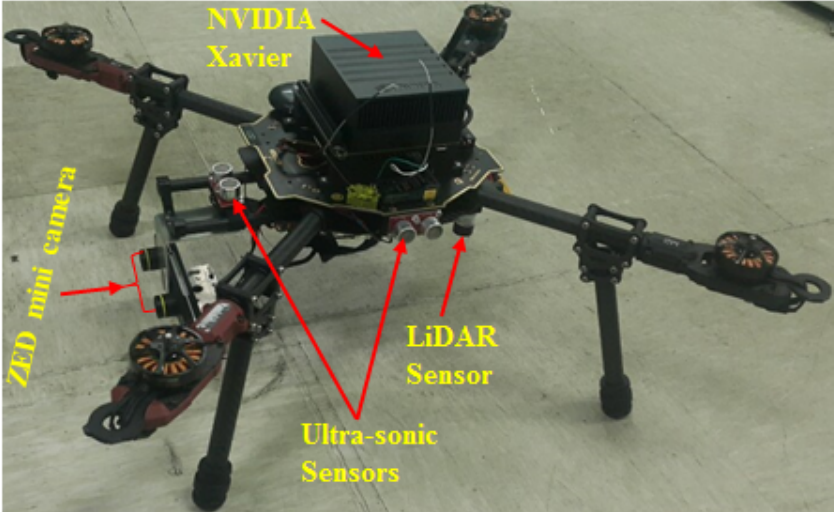
Figure 3. Quadcopter equipped with on-board